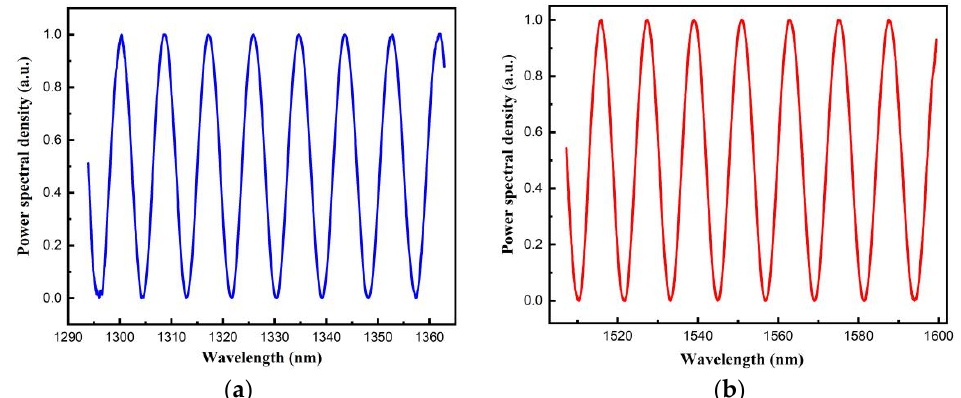
Figure 10. Reflection spectrum of a 100.214 μ m fiber-optic F–P sensor.